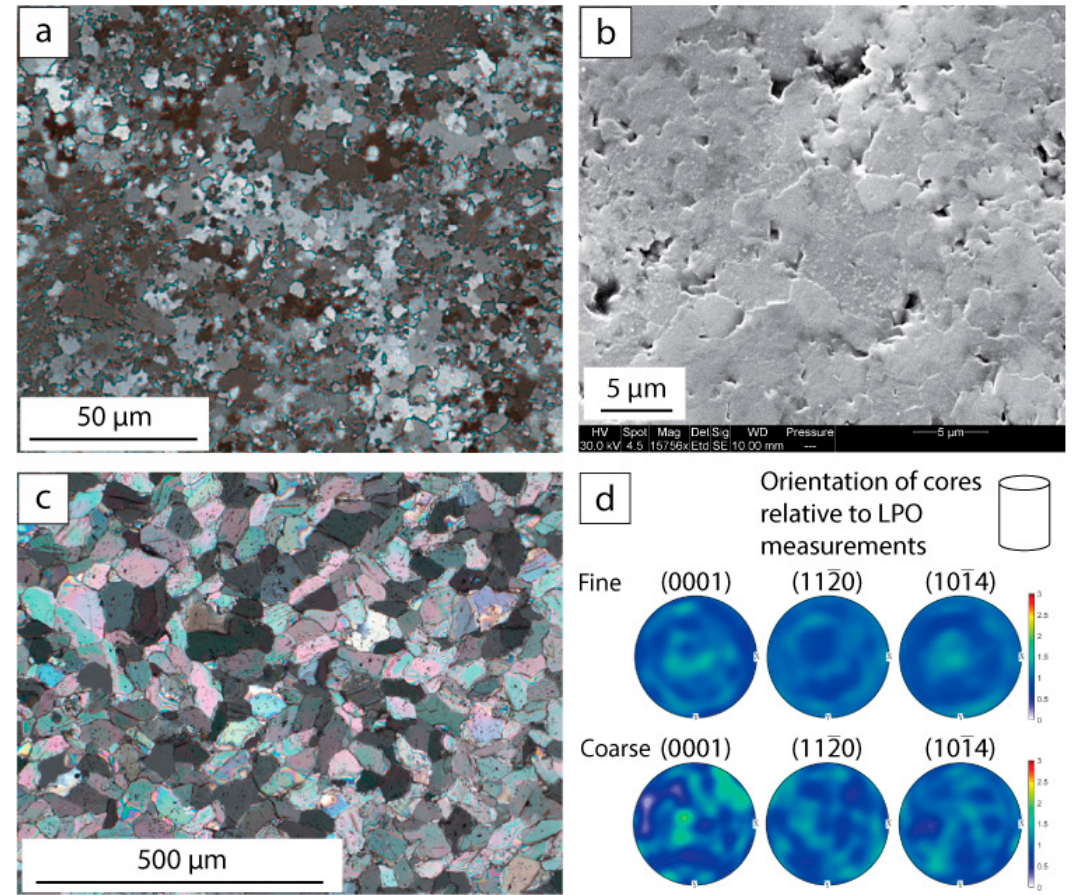
Figure 2. A fine-grained ( d ~ 2 μ m; a - photomicrograph, b – SEM-BSE image) and coarse-grained ( d ~ 80 μ m; c – photomicrograph) natural magnesite aggregate from Nevada, USA were used in the experiments performed in this study. All cores were collected parallel to the NS axis of the lower hemisphere equal area nets ( d ). Both magnesite aggregates have no lattice preferred orientation ( d ; fine n = 1728; coarse n = 200; poles are contoured to the basal (0001), prism (11–20), and rhomb (10–14)